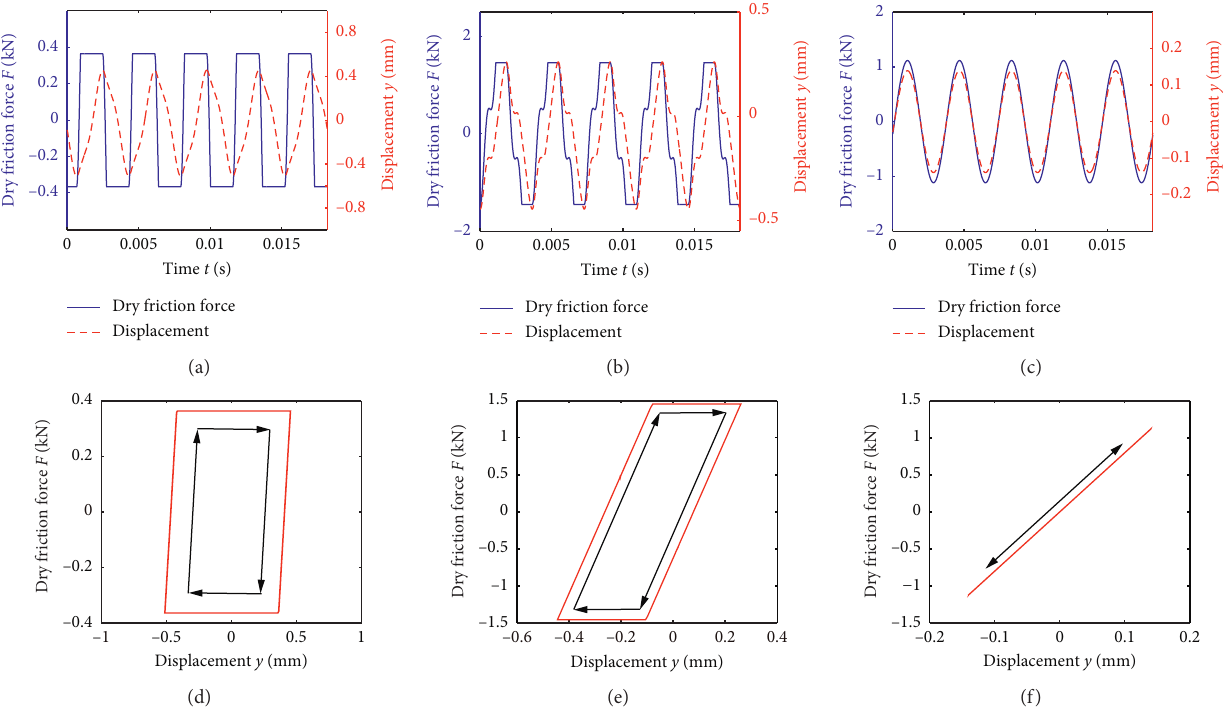
Figure 10: Dry friction force for different rotational speeds: (a–c) represent the dry friction force curve and the response curve, and (d–f) describe the hysteresis